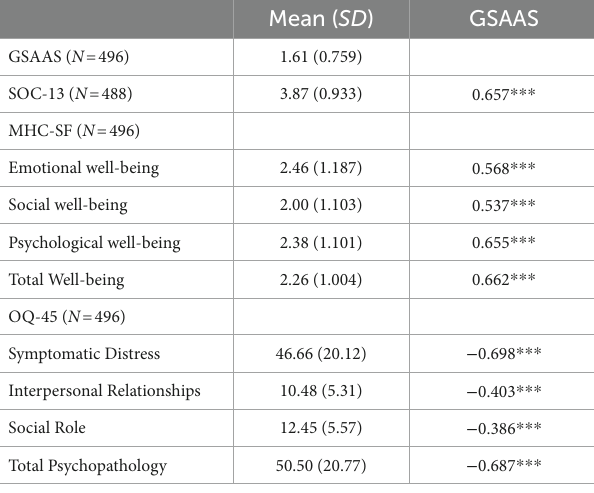
TABLE 5 Means, standard deviations and correlations for outcome variables with the GSAAS.